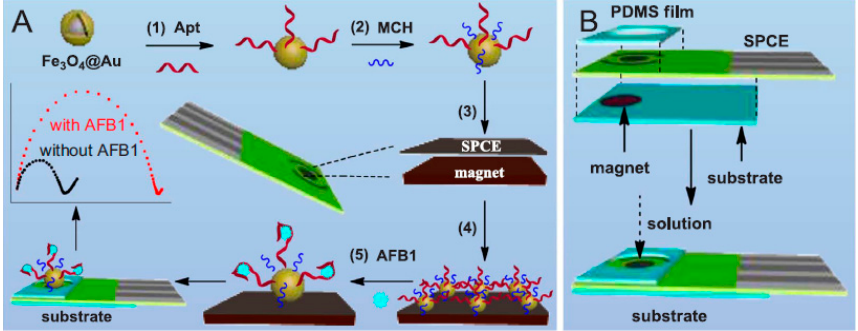
Figure 3. A schema of the fabrication procedure of ( A ) the magnetically assembled aptasensor and its working principle for determination of AFB1, and ( B ) the aptasensing instrument. Reprinted with permission from [37]. Copyright 2018, Elsevier.